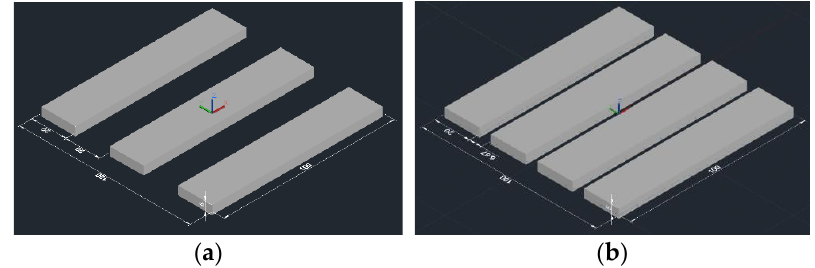
Figure 16. Sample model 2. ( a ) Sample model 2a. ( b ) Sample model 2b.